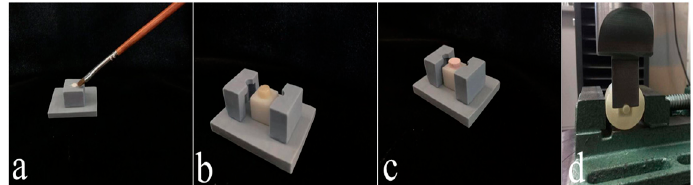
Figure 2. Illustration of the fabricated v–c cylinder and using the universal testing machine. The core material placed within the pre-fabricated silicon mold ( a ); the core placed outside the mold, the cylindrical shape of the v–c was set as 5 mm in diameter and 3 mm in height ( b ); fabricated v–c cylinder after firing cycles ( c ); a specimen placed under universal testing machine ( d